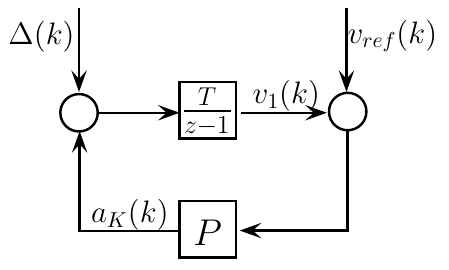
Figure 3. Closed-loop structure of the longitudinal